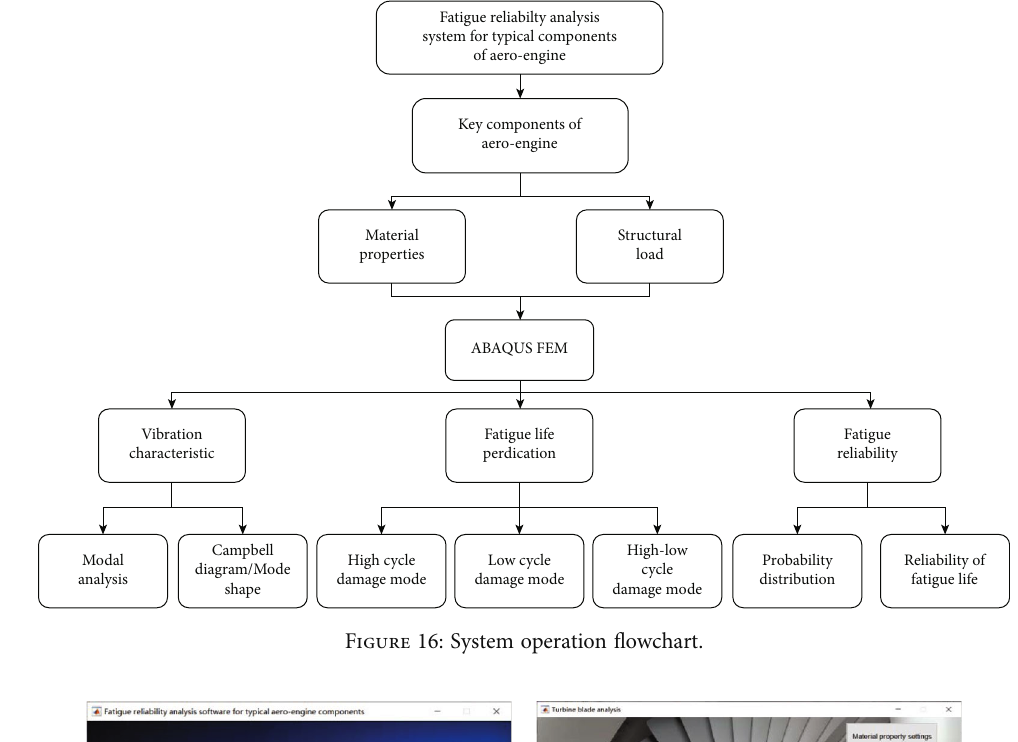
Figure 16: System operation fl owchart.